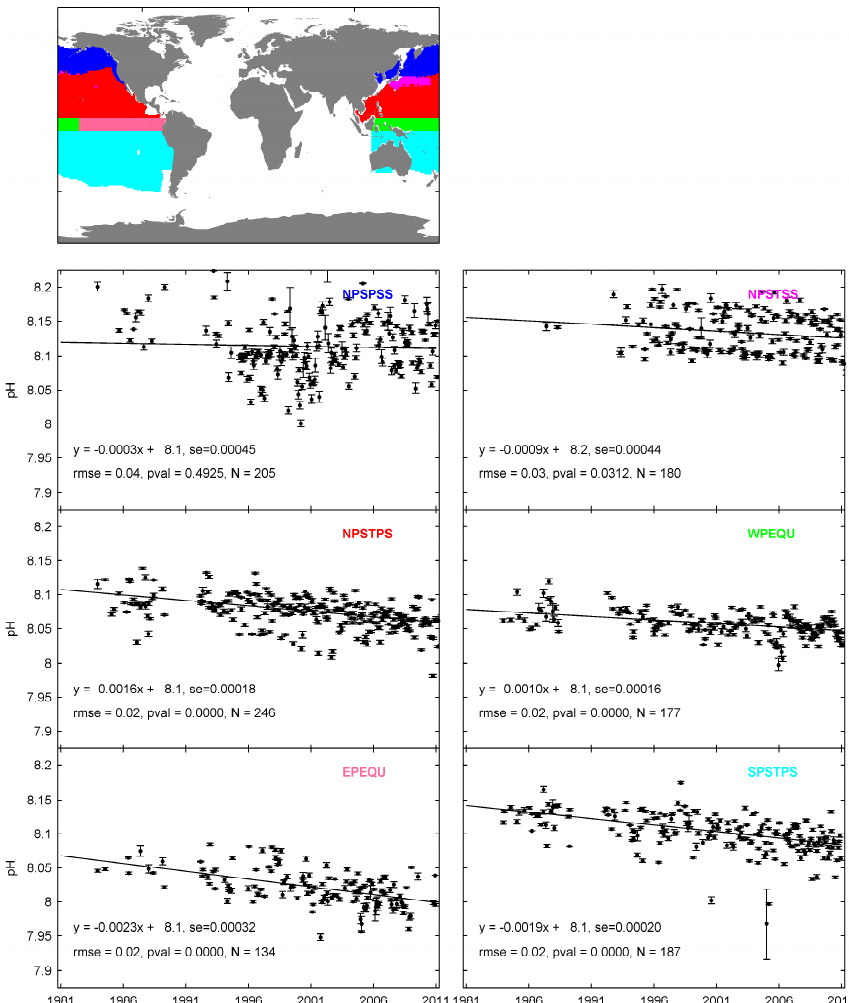
Figure 3. Long-term pH trend (1981–2011) in the five Pacific Ocean biomes.